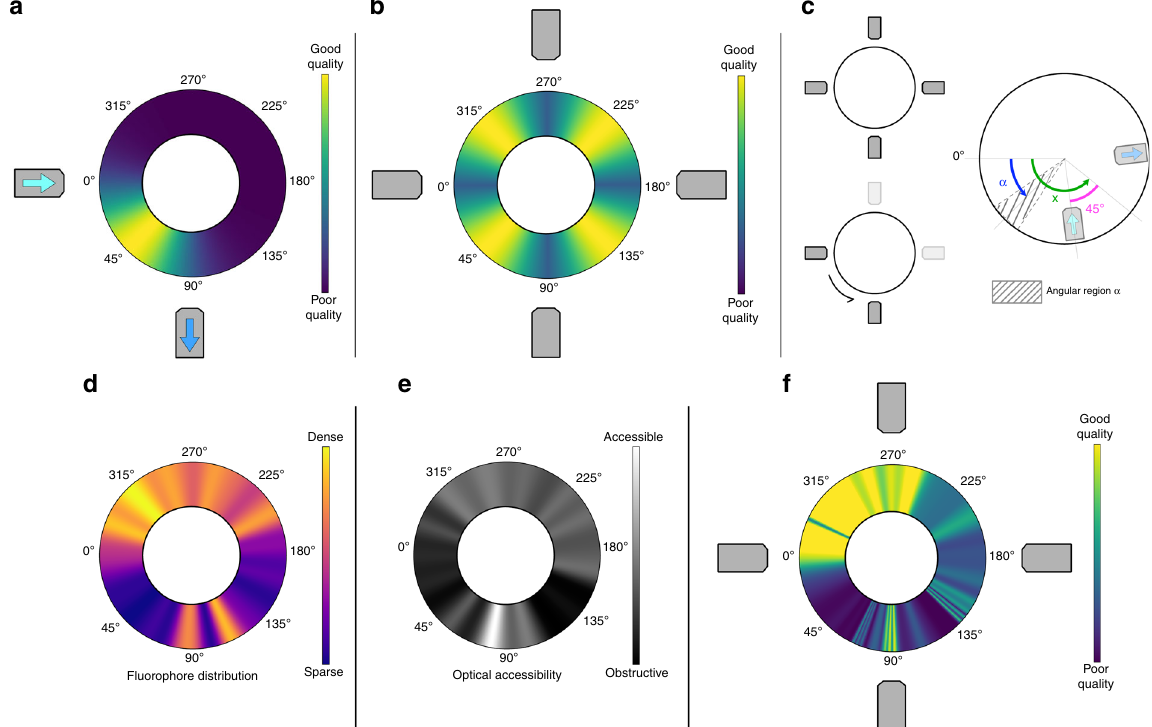
Fig. 2 Simulation and estimation of sample coverage in a multi-view dataset. a The simulated sample coverage with a single illumination and a single detection objective. b The simulated sample coverage with four views surrounding the sample. c The two methods to perform multi-view imaging: Multiple objectives surrounding the sample or multiple views created by rotating the sample. Illustration of variable de fi nitions used in Eq. (1). d Estimated angular fl uorophore distribution of a 2 day old zebra fi sh embryo. e Estimated optical accessibility of a 2 day old zebra fi sh embryo. f Estimated sample coverage of a real zebra fi sh embryo measured by number of foreground